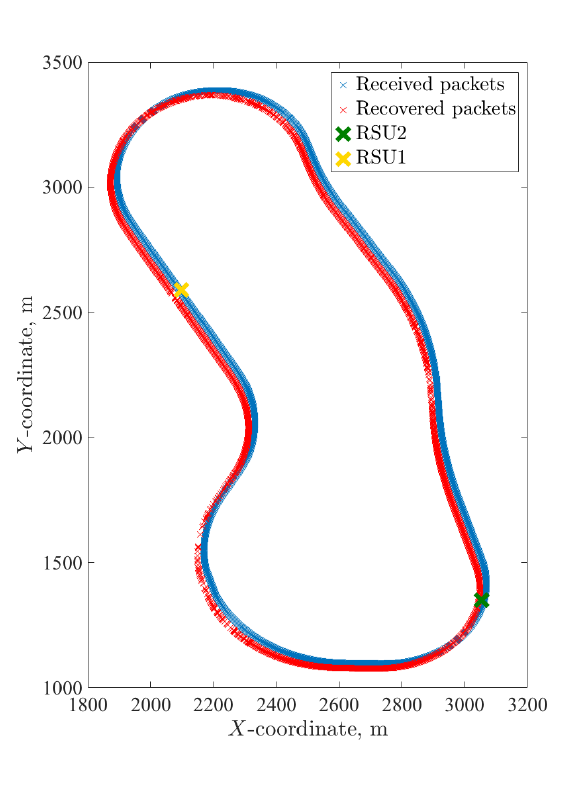
Figure 10. AstaZero scenario results.